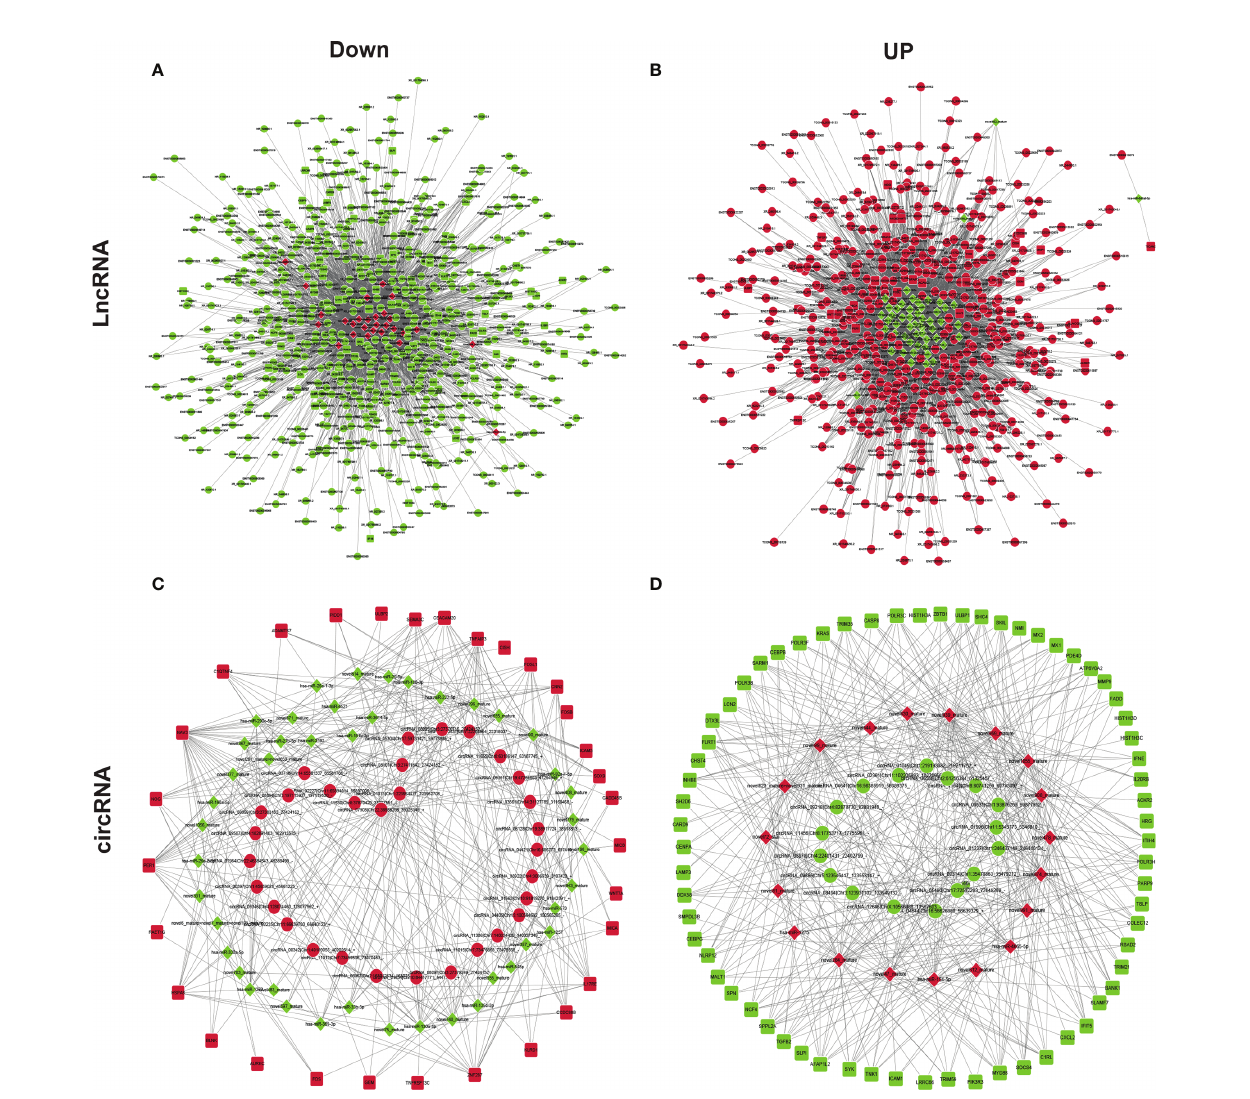
FIGURE 6 | ceRNA – miRNA – mRNA regulatory immunological networks in GA-Me-treated HCT116 cells. (A) Downregulated components of the lncRNA – miRNA – mRNA interaction network in GA-Me-treated HCT116 cells. (B) Upregulated components of the lncRNA – miRNA – mRNA interaction network in GA-Me-treated HCT116 cells. (C) Downregulated components of the circRNA – miRNA – mRNA interaction network in GA-Me-treated HCT116 cells. (D) Upregulated components of the circRNA – miRNA – mRNA interaction network in GA-Me-treated HCT116 cells. Red and green represent up- and downregulation,